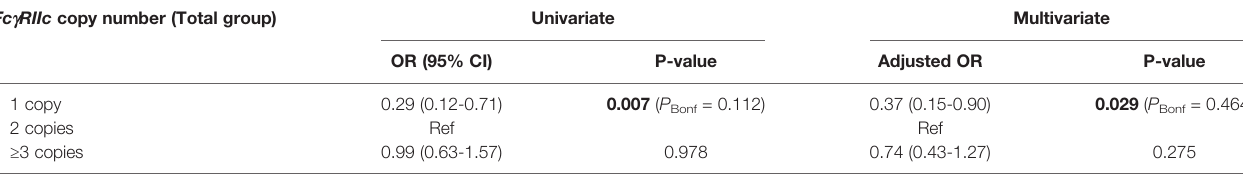
TABLE 3 | Effect of FCGR2C CNR1 copy number distribution on perinatal HIV-1 acquisition, adjusting for birthweight and FCGR2C genotypes. Fc g RIIc copy number (Total group)